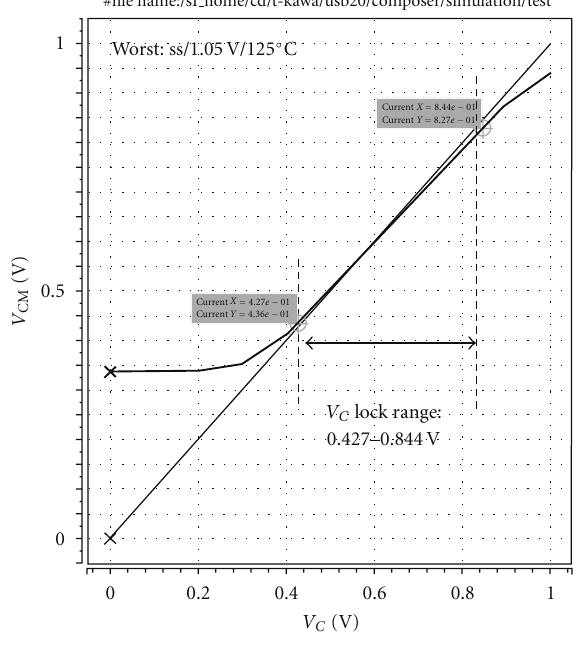
Figure 11: Simulation results from CP.